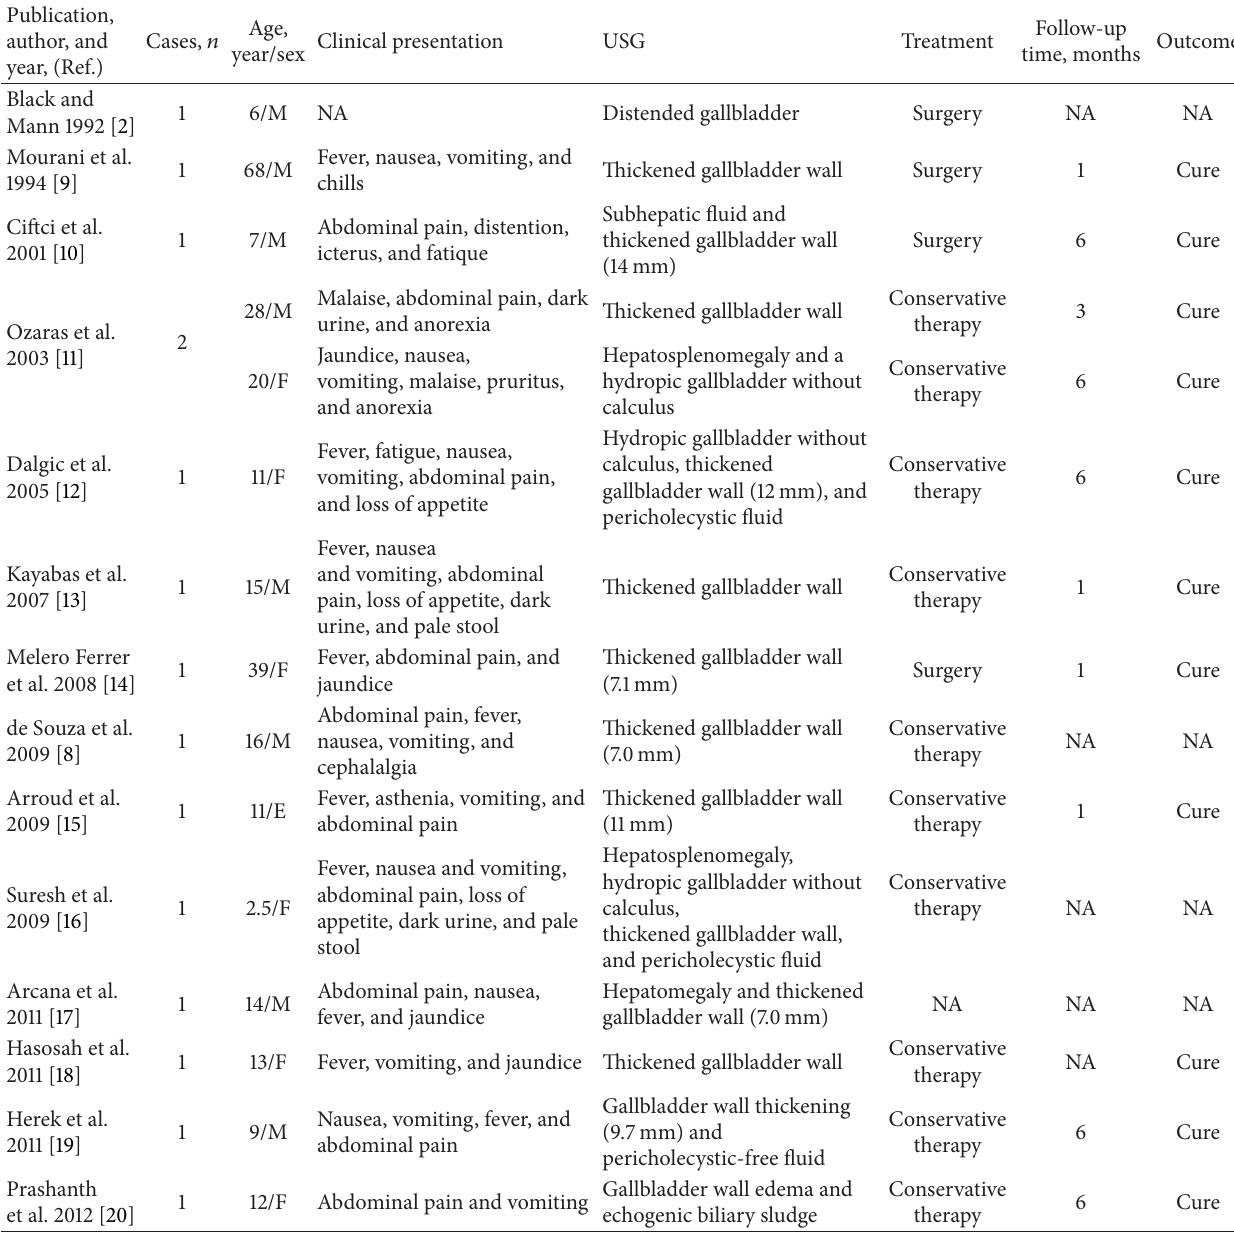
Table 2: Review of the clinical presentation, ultrasound findings with treatment modalities, and outcomes of patients with acalculous cholecystitis due to viral hepatitis A published in the literature (F: female; M: male; NA: not available; USG: